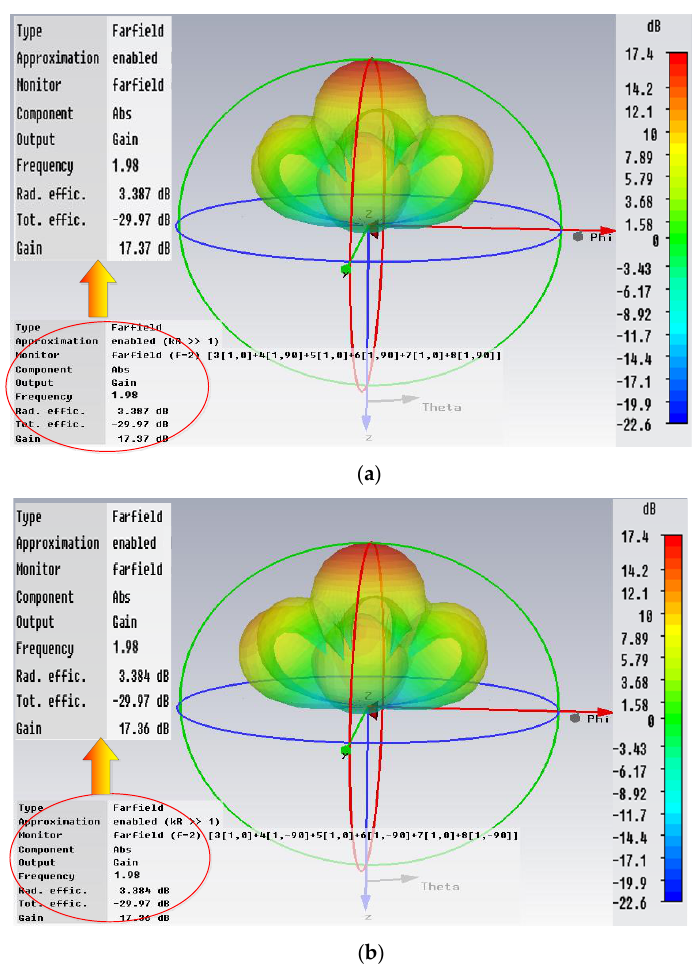
Figure 10. The pattern of the antenna array with the impedance of 50 : ( a ) O-mode wave; ( b ) X-mode wave. No matter for O or X-mode wave, the antenna array has a high gain and vertical upward main lobe.